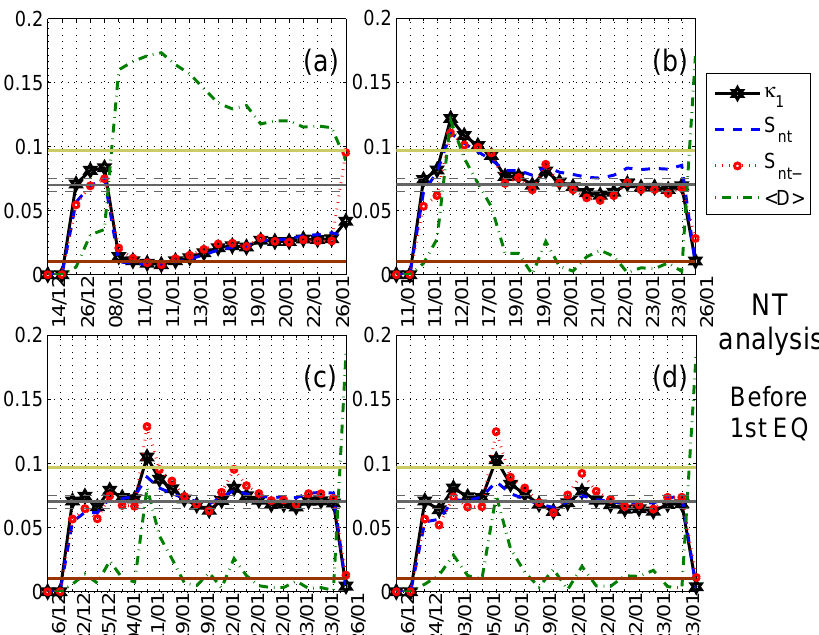
Figure 10. Temporal evolutions of the four natural time (NT) analysis parameters ( κ 1 , S nt , S nt- , and (cid:104) D (cid:105) ) for the foreshock seismic activity recorded prior to EQ1: (a) for the activity of the whole investigated area of the Ionian Sea for M L threshold 2.5, during the period from 13 December 2013 00:00:00 to 26 January 2014 13:55:44UT (just after the occurrence of EQ1); (b) for the activity of the whole investigated area of the Ionian Sea for M L threshold 2.3, during the period from 11 January 2014 04:13:00 (just after the M L = 4 . 7 that occurred in Zante) to 26 January 2014 13:55:44UT; (c) for the activity of both Cephalonia (eastern and western) zones combined for M L threshold 2.1, during the period from 13 December 2013 00:00:00 to 26 January 2014 13:55:44UT; and (d) for the activity of western Cephalonia for M L threshold 2.1, during the period from 13 December 2013 00:00:00 to 26 January 2014 13:55:44UT. Note that the events employed depend on the considered threshold. Moreover, the time ( x ) axis is not linear in terms of the conventional date of occurrence of the events, since the employed events appear equally spaced relative to the x axis, as the natural time representation demands, although they are not equally spaced in conventional time. The horizontal solid light green, solid grey, the grey dashed lines denote the same quantities as in Fig. 6, while the horizontal solid brown line denotes the 10 − 2 limit for (cid:104) D (cid:105) . (For interpretation of the references to colours, the reader is referred to the online version of this